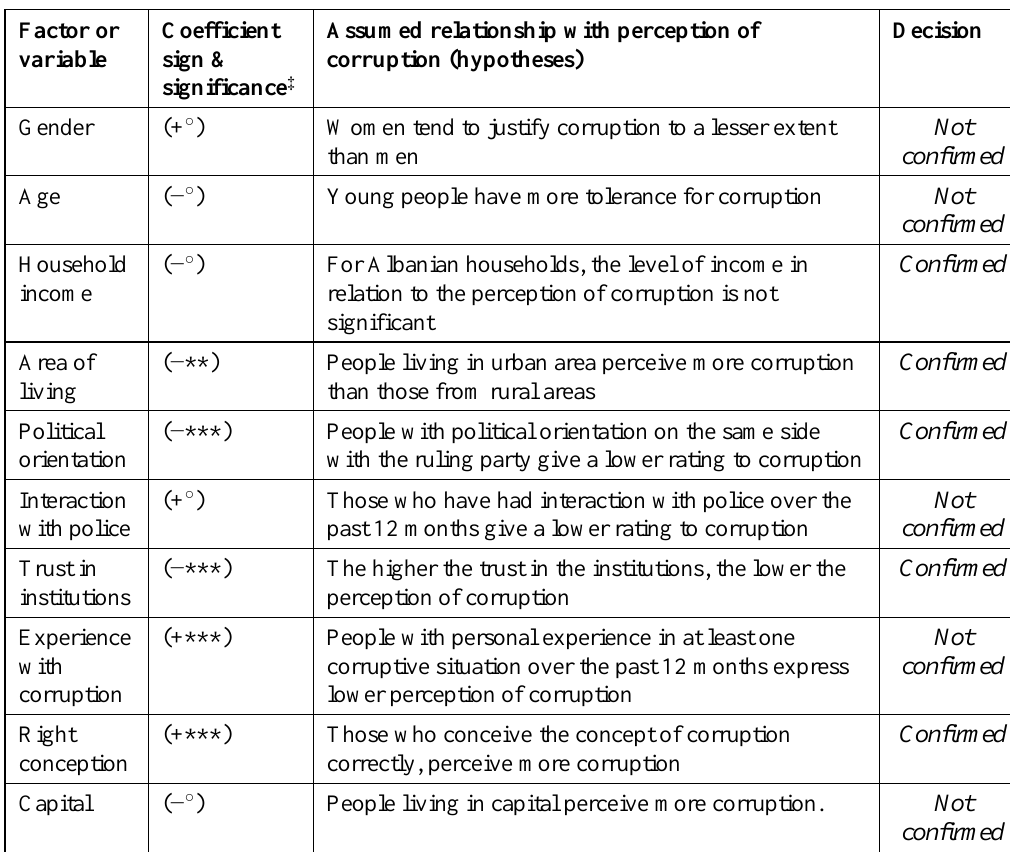
Table 2. Acceptance and Refusal of